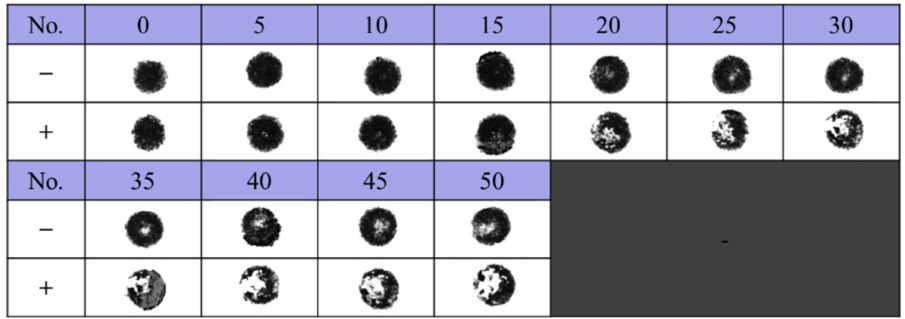
Figure 11. Carbon imprints of the as-received electrode at the electrode force of 400 kgf during continuous RSW.